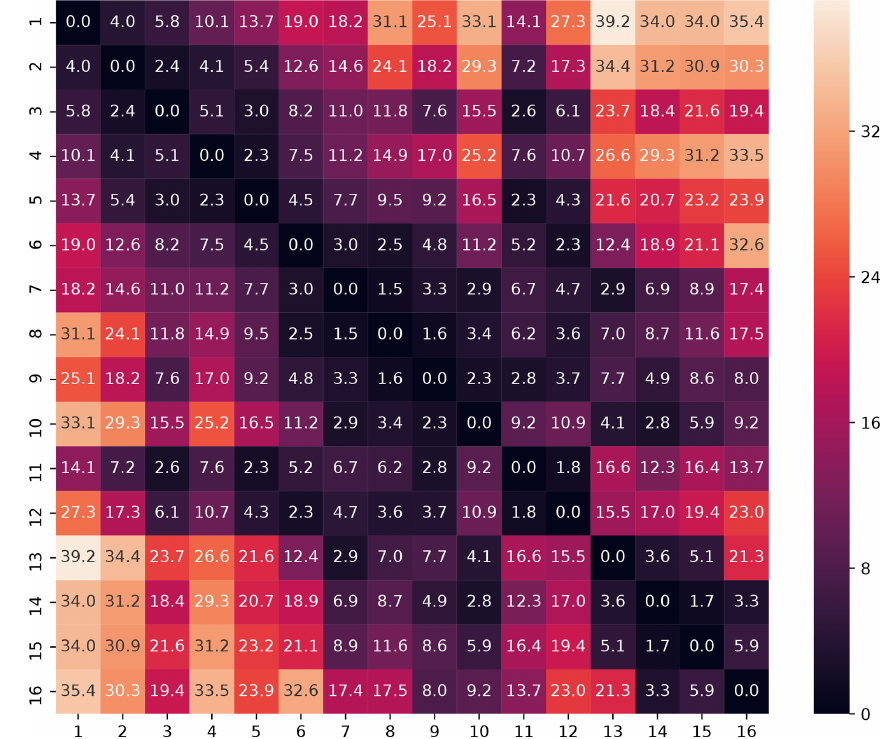
Figure 6. Class distance matrix for the 16-class classification, showing the Bhattacharyya distance between class medoids as a heatmap.